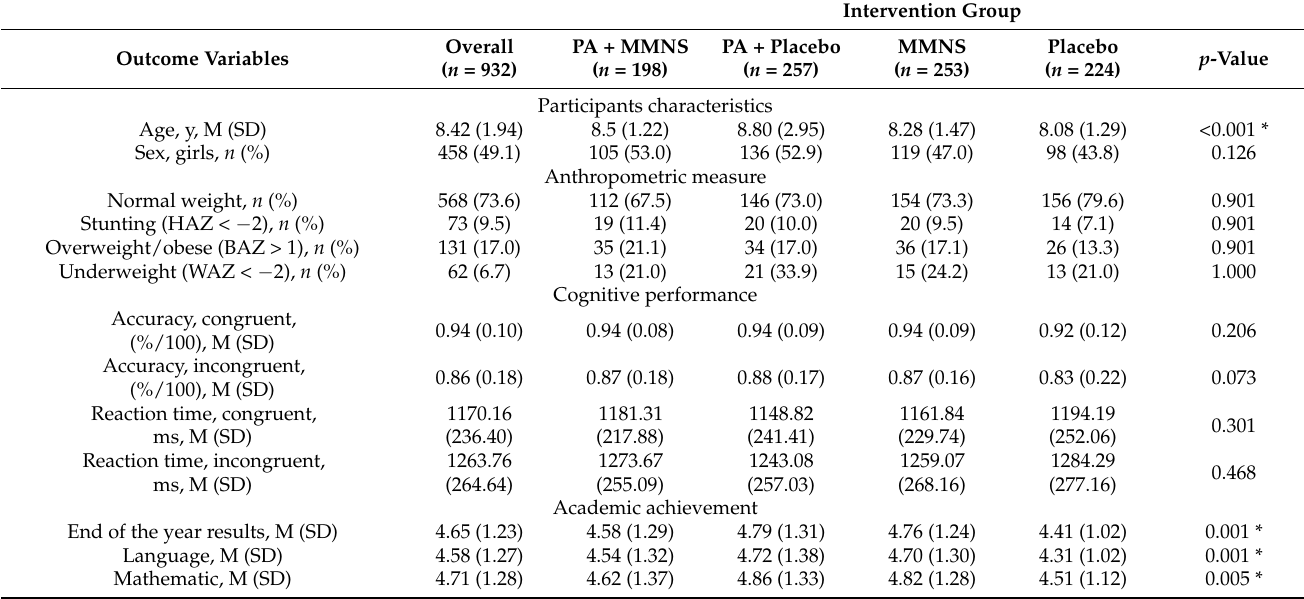
Table 1. Descriptive characteristics and baseline differences between groups.